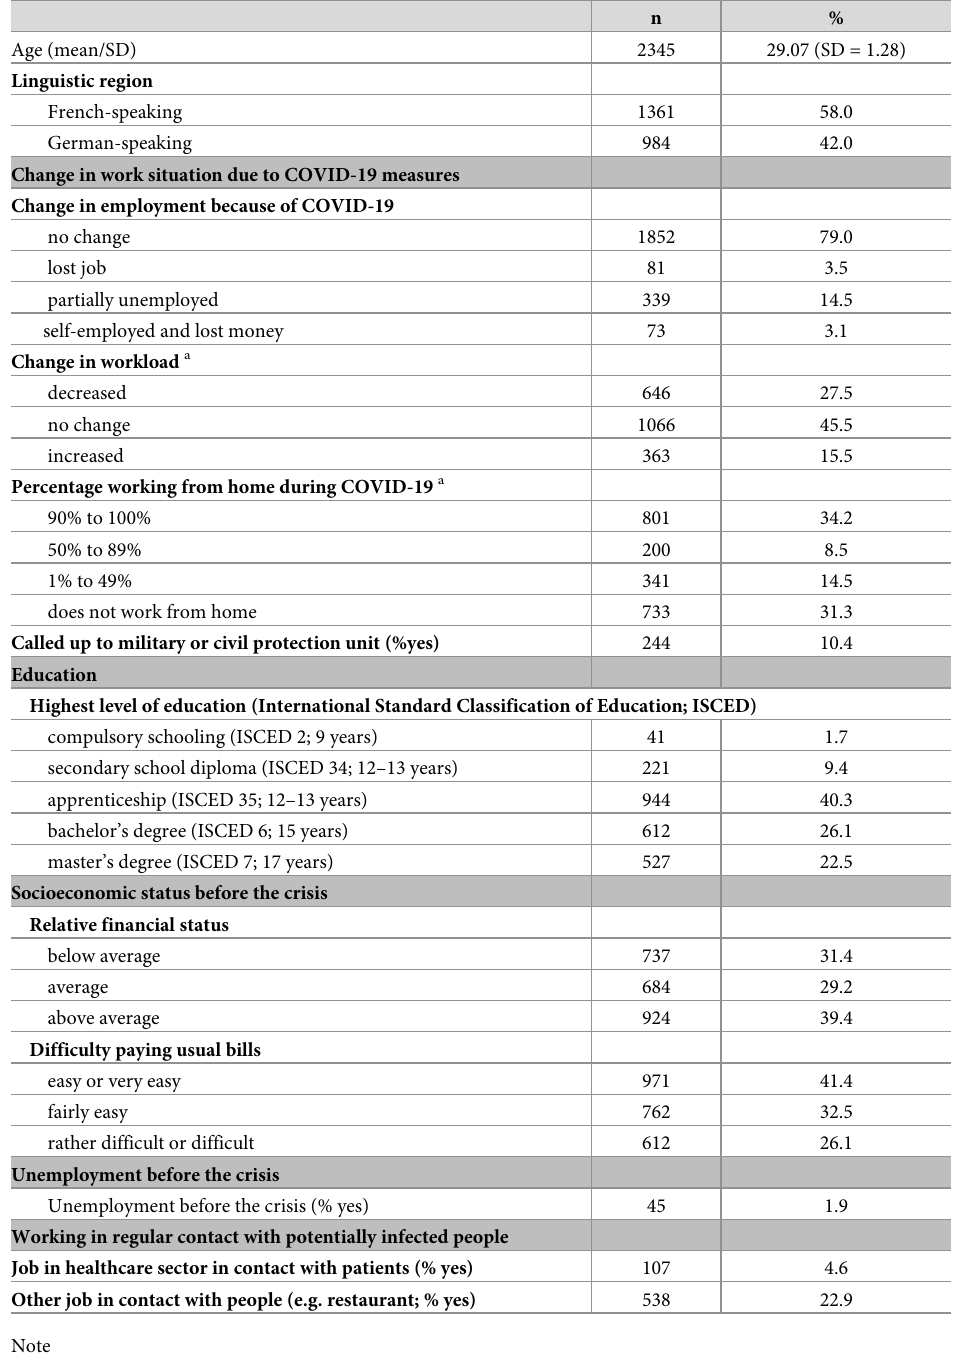
Table 1. Demographic characteristics of the sample (Total n =